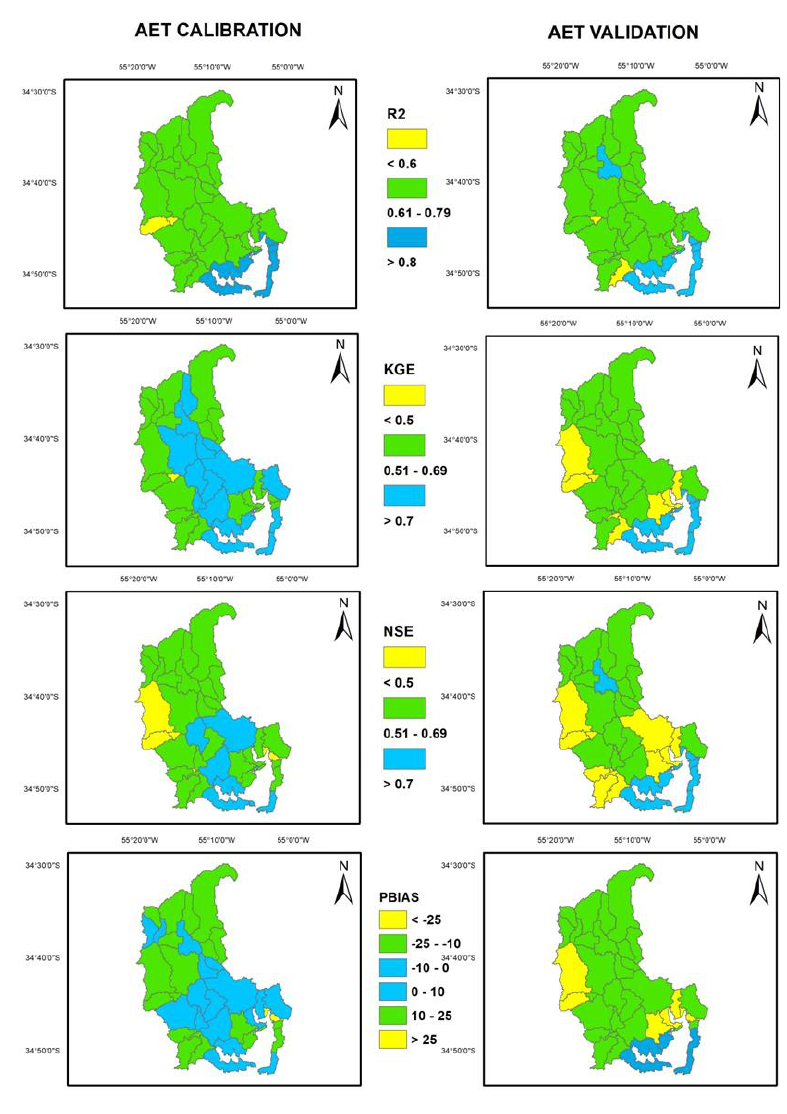
Figure 3. SWAT model performance for the period 2003–2013 on a sub-basin scale.